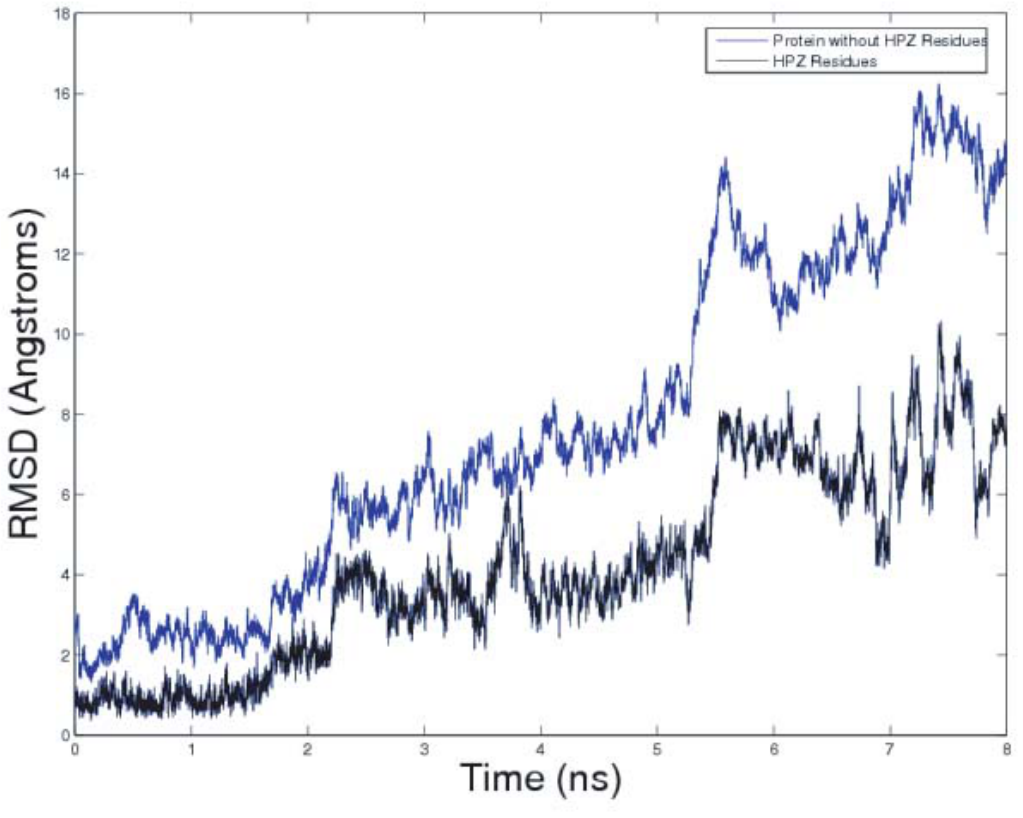
Figure 9. RMSD of Protein without top 5 HPZ residues compared to the RMSD of the top 5 HPZ residues. The HPZ residues have much lower RMSD values than the other residues.